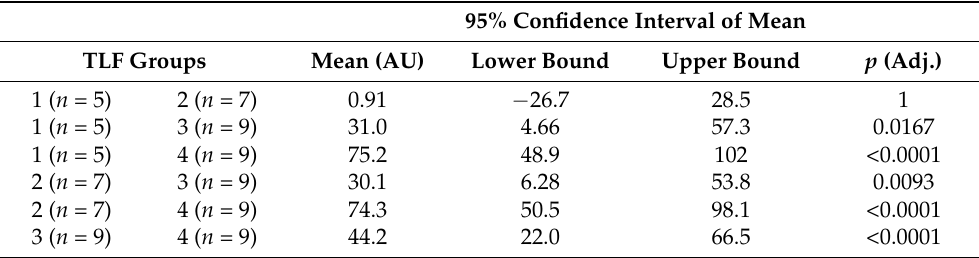
Figure 4. Relative changes in percent compared to baseline measurement. For better readability, the error bars are only shown on one side and represent the standard deviation. t 0 , baseline measurement; t 1 , measurement after treatment; t 2 , measurement 40 min after treatment; SO 2 , oxygen saturation; rHb, relative hemoglobin. Group differences, significant at the level * p < 0.05, ** p < 0.01, **** p < 0.0001. Table 3. Influence of thoracolumbar fascia morphology on blood flow in lumbar